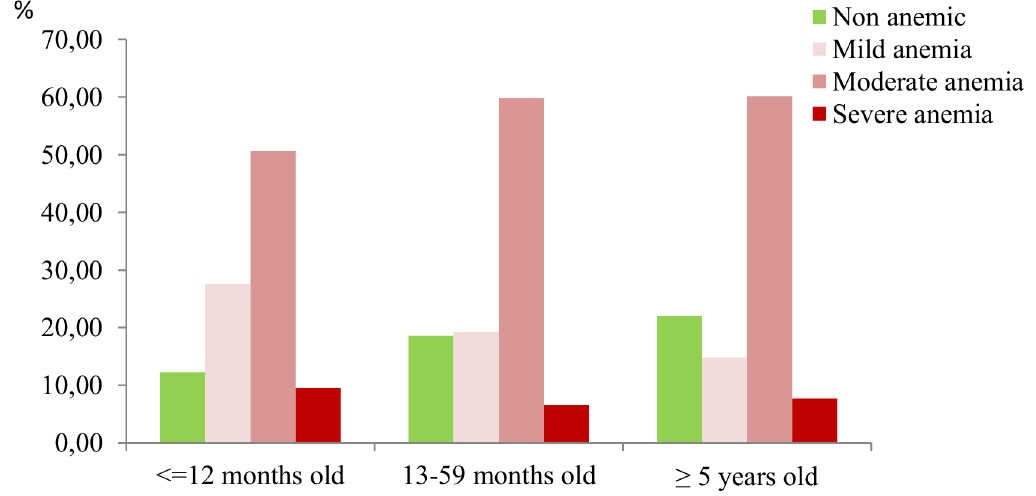
Fig 1. Percentage of anemia severityby age group in children, Bata district, June-August 2013.